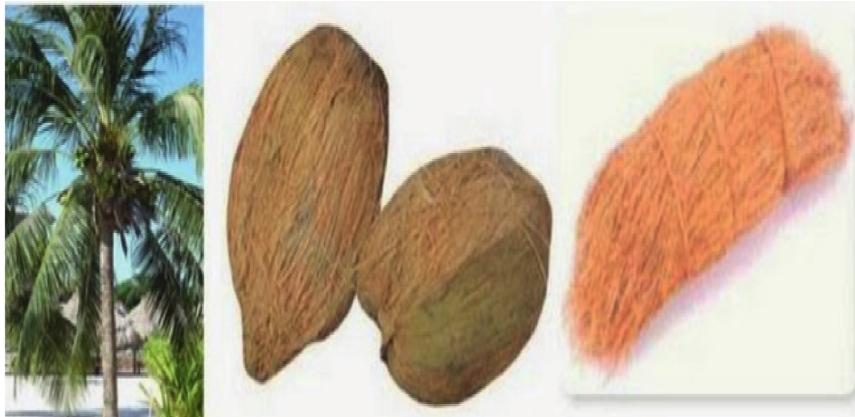
Figure 4: Coconut coir